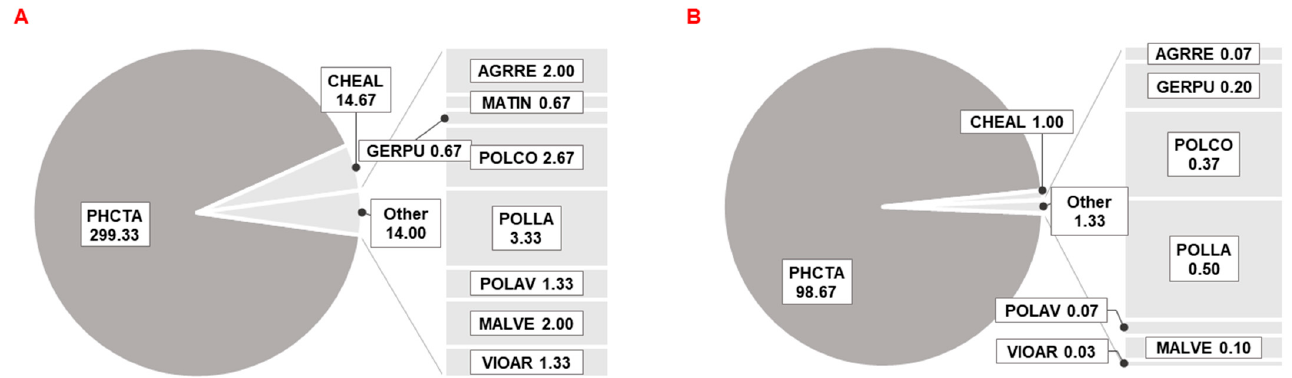
Figure A4. Number of plants per m 2 —Sowing 1 (5th of April) in 2019 ( A ) and leaf coverage in %— Sowing 1 (5th of April) in 2019 ( B ).